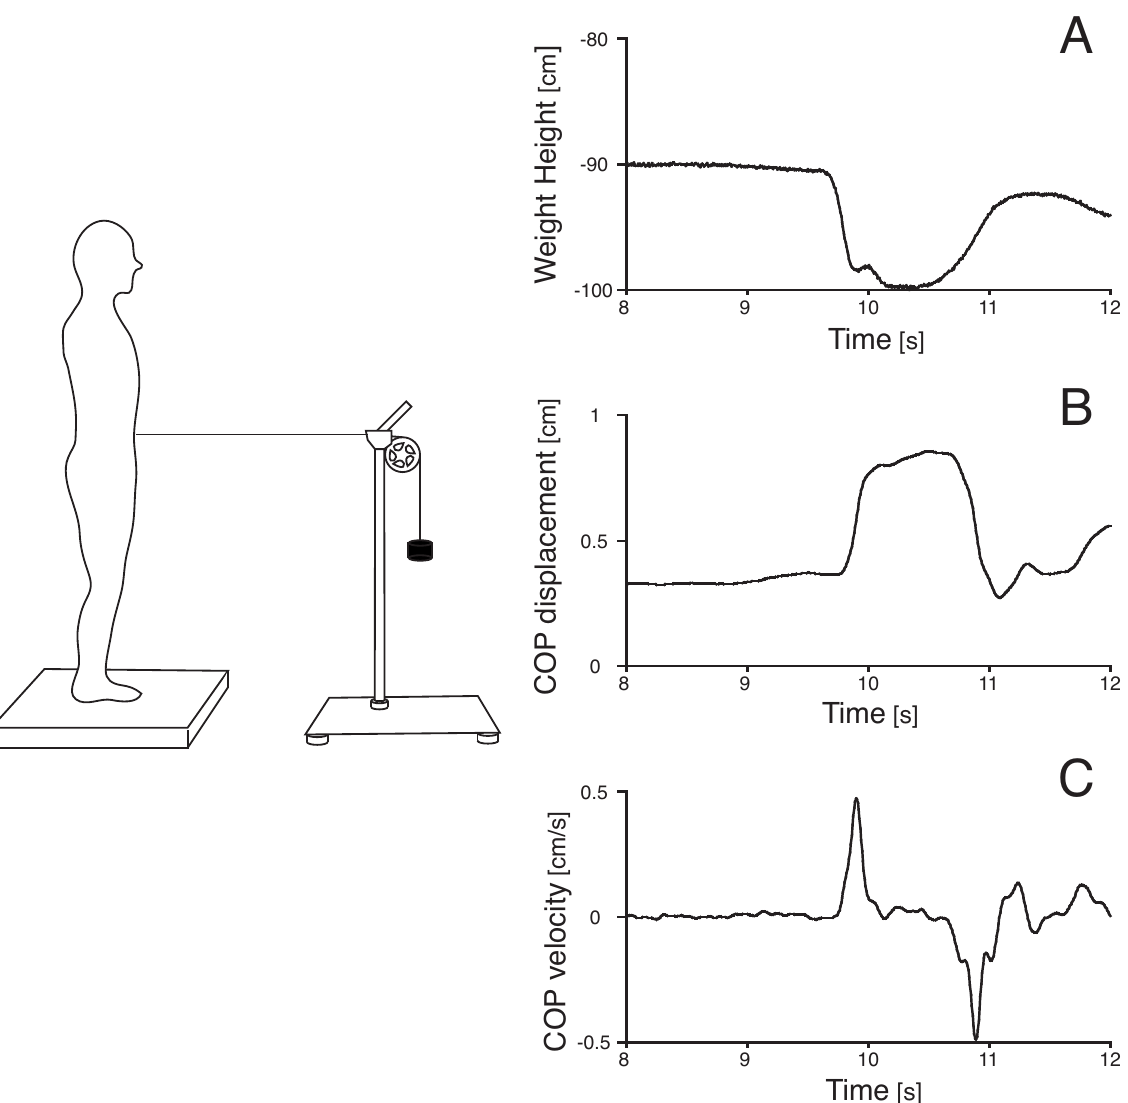
Figure 1 . Left scheme: The scheme of the perturbation setup for the anterior perturbation. Right column: Typical examples of weight height (A), COP (B), and COPv (C) traces for the anterior